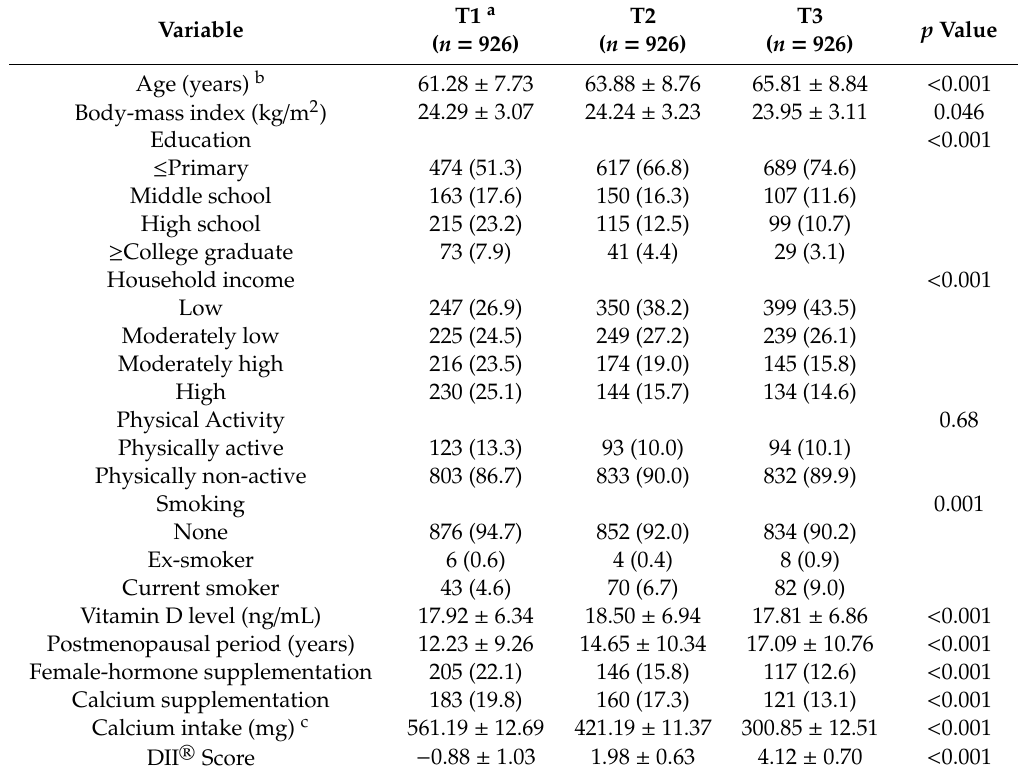
Table 1. Characteristics of participants according to dietary inflammatory index (DII ® )